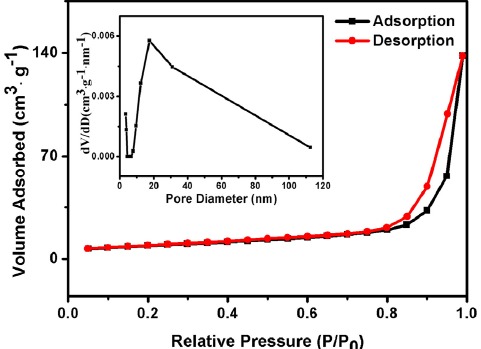
Figure 5. The N 2 adsorption/desorption isotherms and pore size distribution (inset) of Fe 3 O 4 @SiO 2 @GdVO 4 :Dy 3+ .